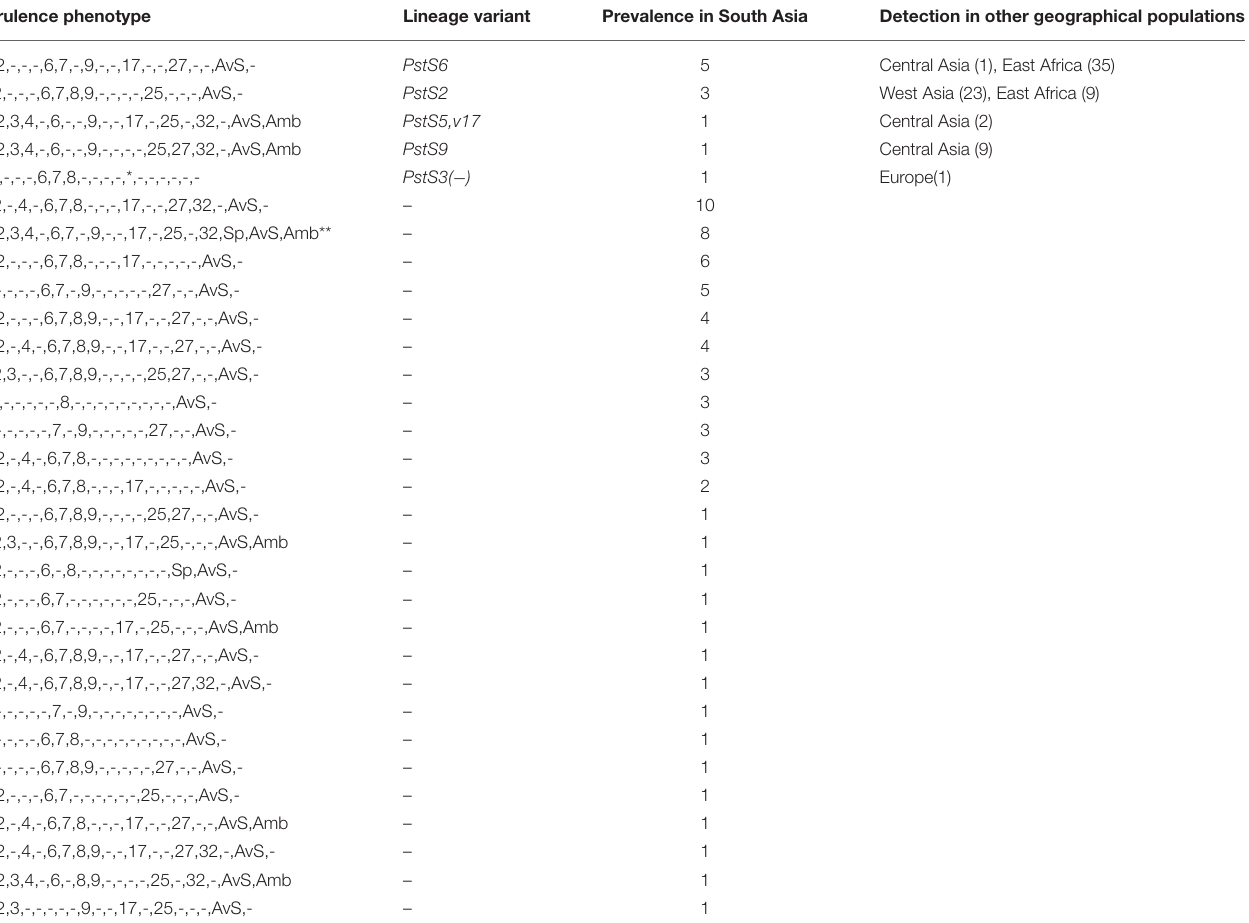
TABLE 4D | Prevalence of P. striiformis races detected in South Asia during